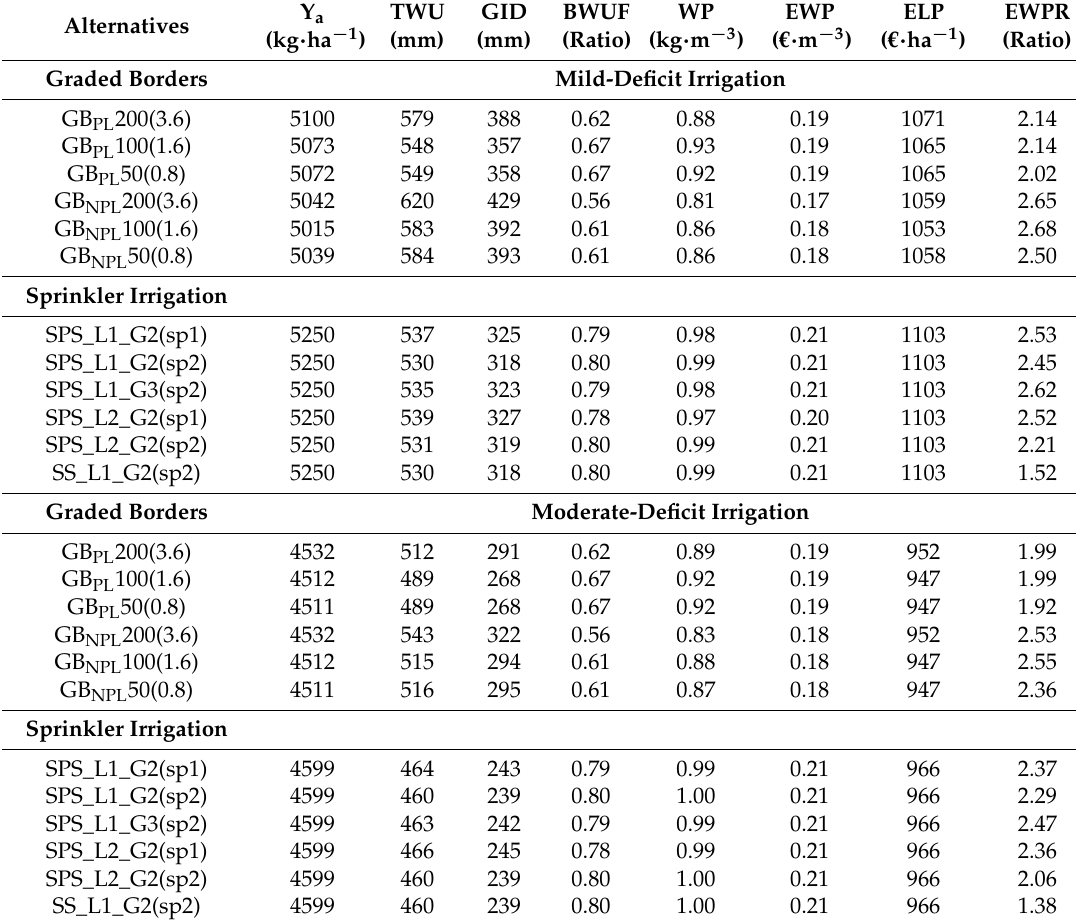
Table 7. Comparing indicators relative to selected alternatives for mild and moderate-deficit irrigation. Alternatives